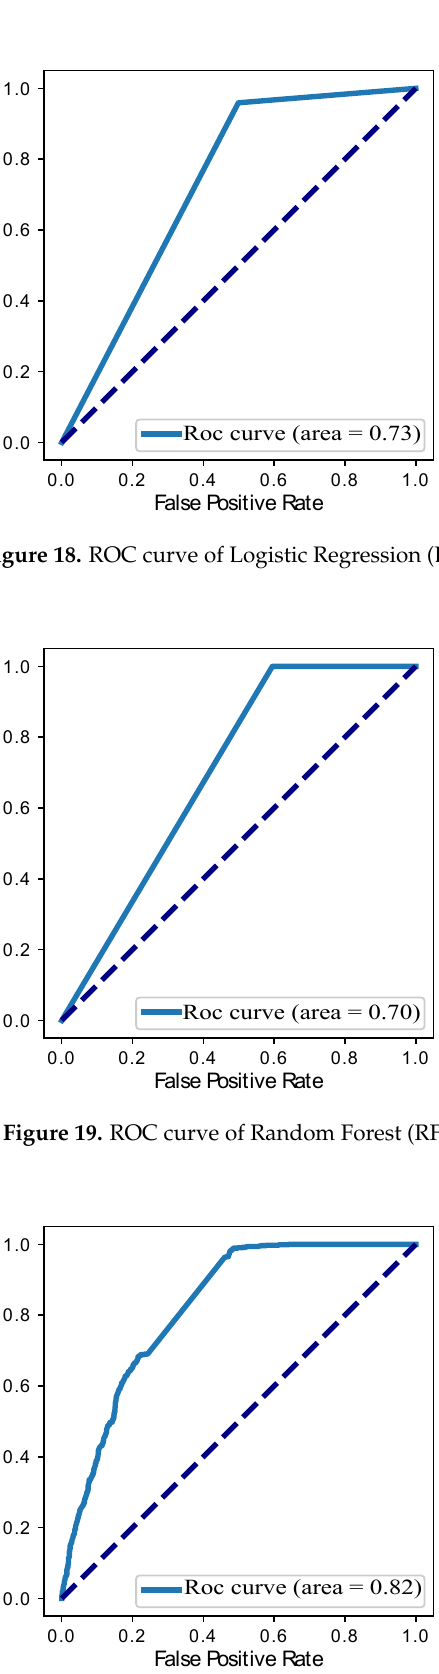
Figure 20. ROC curve of Long Short-Term Memory